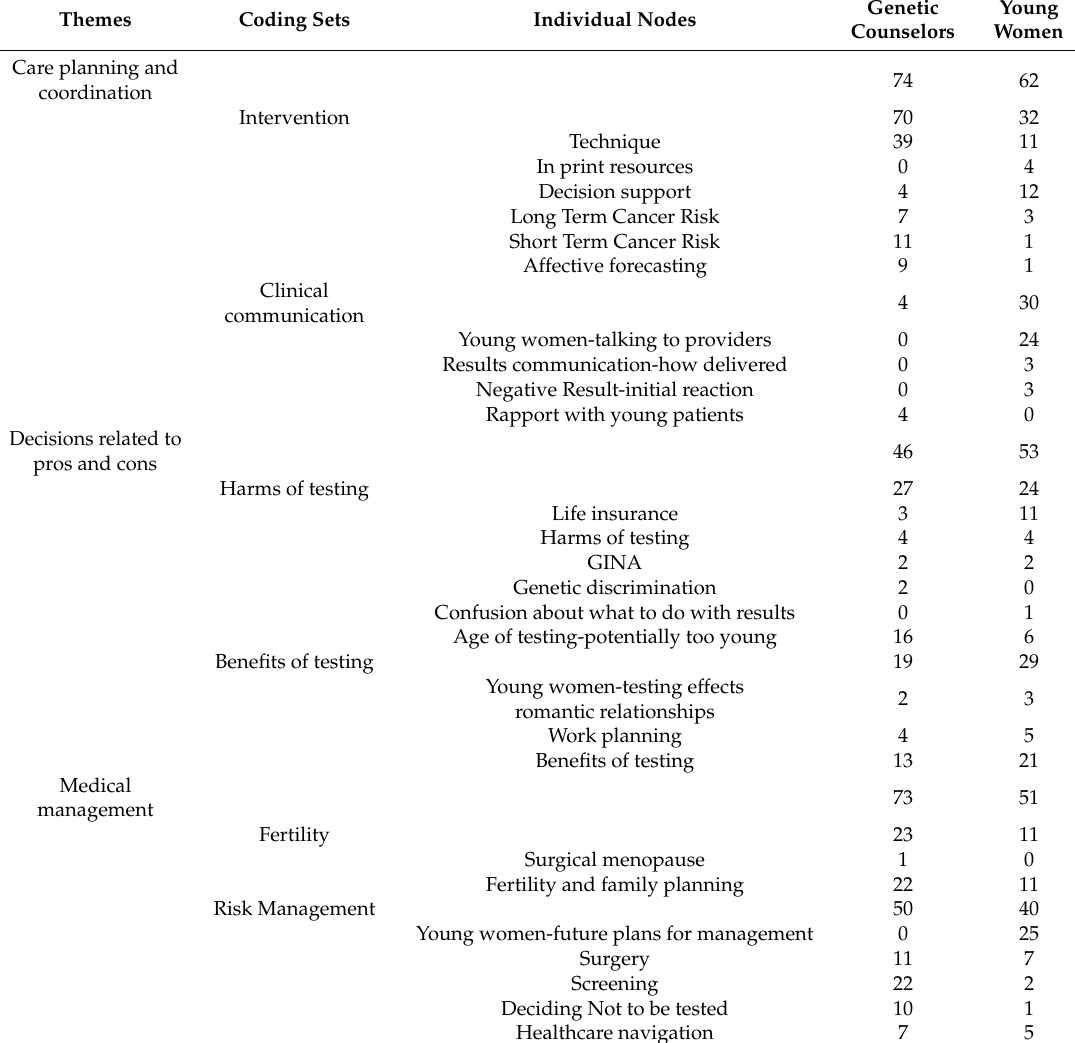
Table 3. Code frequencies for response